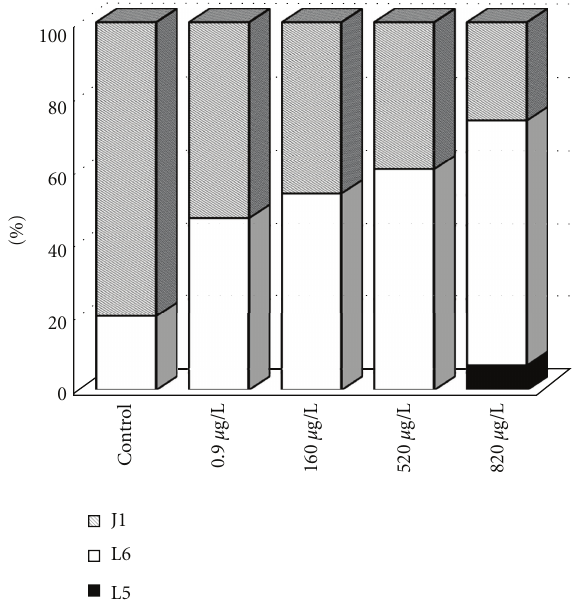
Figure 4: Developmental stages of common carp at day 27 (L5, L6- larval, and J1-juvenile developmental stages); n = 75.